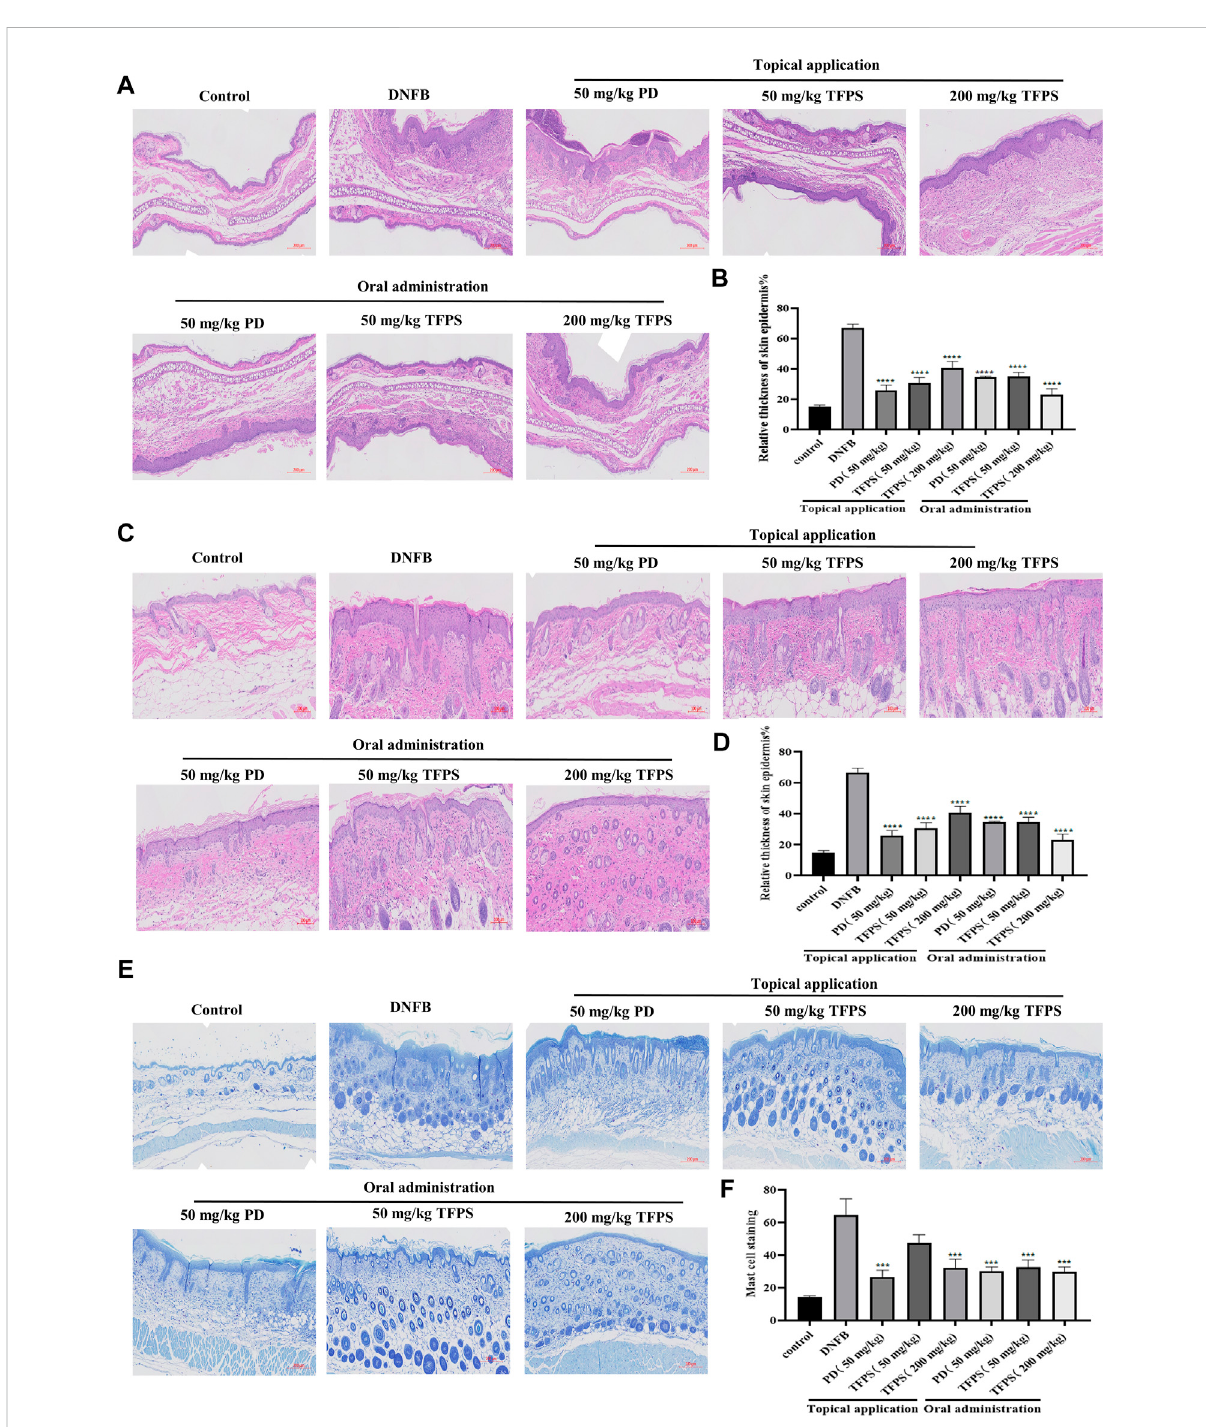
FIGURE 3 Effects of TFPS on the histomorphological changes in mice with DNFB induced AD-like symptoms. (A) HE stained section of ear tissue (magni fi cation ×300) (B) The measurementofearskinepidermalthickness indifferentexperimentalgroups ispresented asrelativetothat ofcontrol group, for which the value is set as 100%. (C) HE staining of dorsal skin tissues (magni fi cation ×400) (D) The measurement of dorsal skin epidermal thicknessinexperimentalgroupsispresentedasrelativetothatofthecontrolgroup,forwhichthevalueissetas100%. (E) Stainingofmastcells inthedorsalskintissue (magni fi cation ×300) (F) Calculate thenumberofmastcells atrandomlocations.Allvaluesare representedas means±S.E.M ( n = 3). ### p < 0.001, compared with the control group. p p < 0.05, pp p < 0.01, ppp p < 0.001, compared with the DNFB